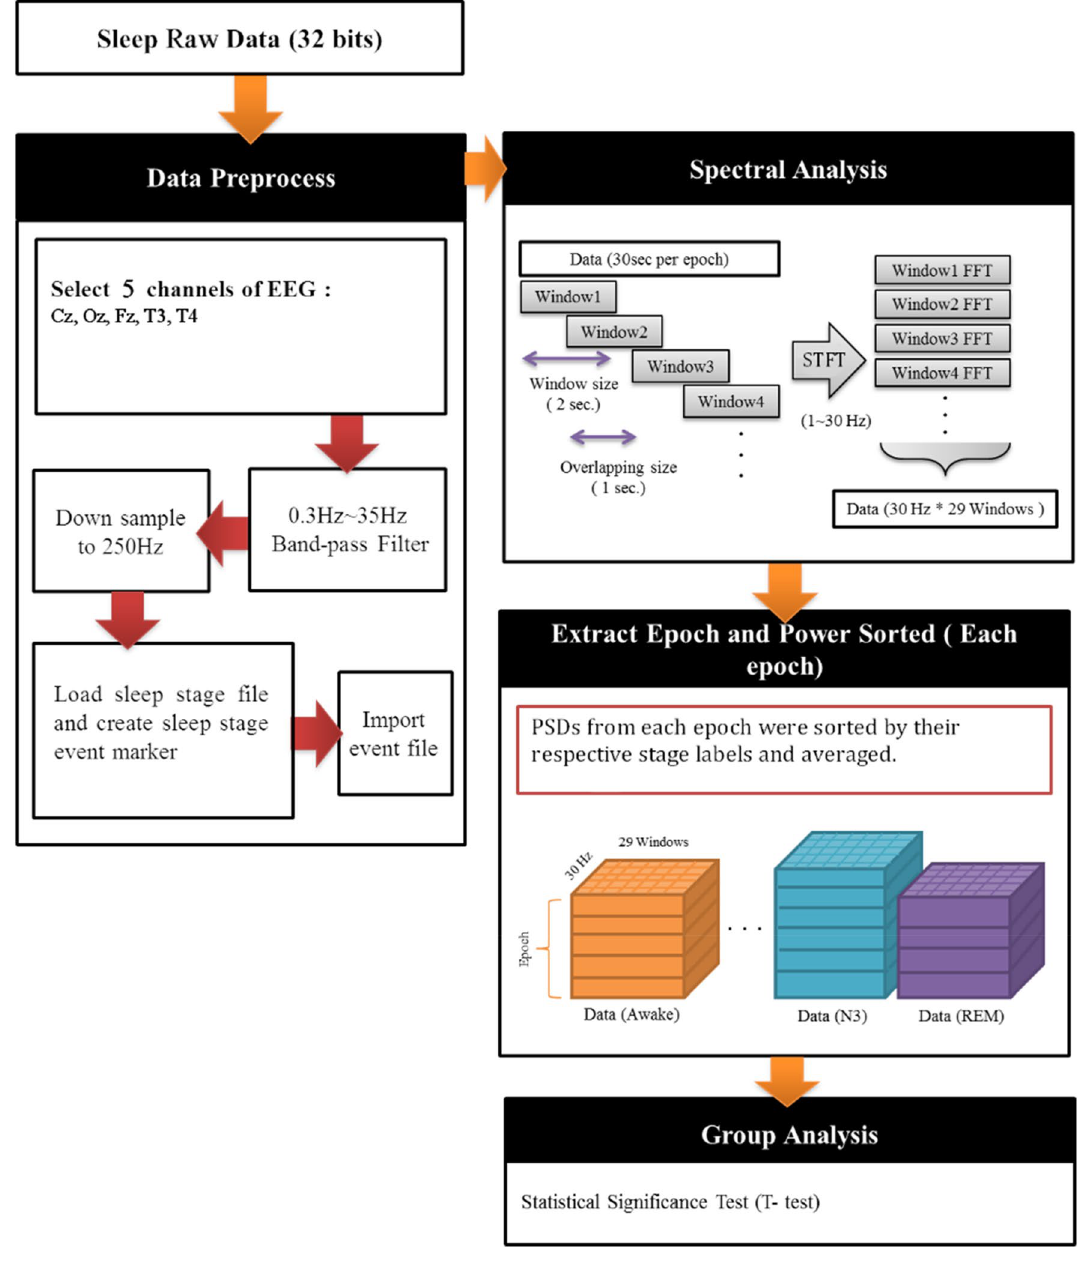
Figure 2. EEG power spectrum density analysis